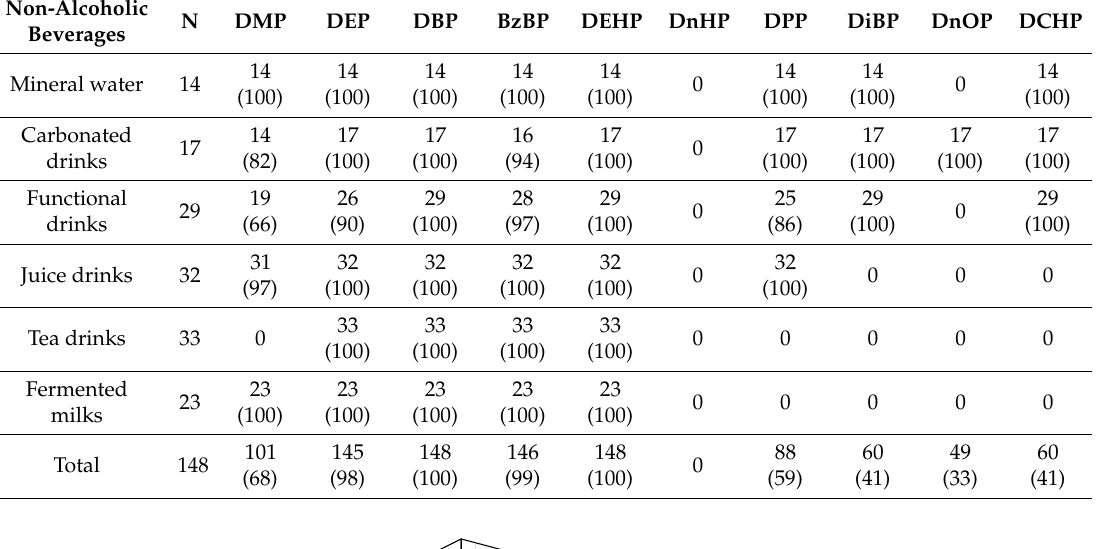
Table 7. Detection of frequency [n (%)] of phthalates in non-alcoholic beverages in Hanoi.